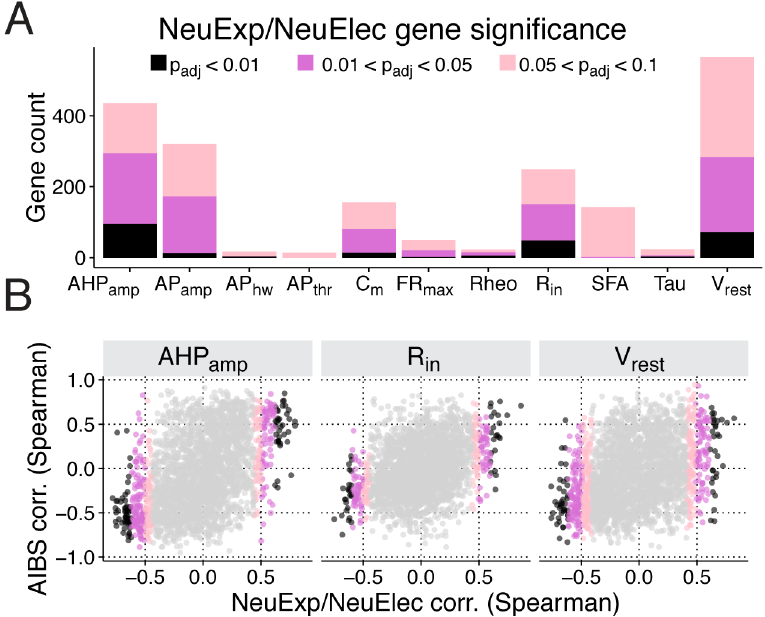
Fig 2. Identification and validation of transcriptomic—electrophysiological correlations. A) Count of genessignificantly correlatedwith variouselectrophysiologicalproperties,brokendown by statistical significanceof Benjamini-Hochberg FDR-adjusted correlationp-values(p adj ). Names and descriptions of ephys propertiesare providedin S 1 Table . B) Comparisonof correlations calculatedusing NeuroExpresso/ NeuroElectro discovery dataset (NeuExp/NeuElec, x-axis) versus correlationscalculatedusing Allen Institute validation dataset (AIBS, y-axis). Dots reflect correlationvalues of individualgenes. Subpanelsindicate correlationscomputedacross variouselectrophysiologicalpropertiesand p-values are providedin Table 3 .